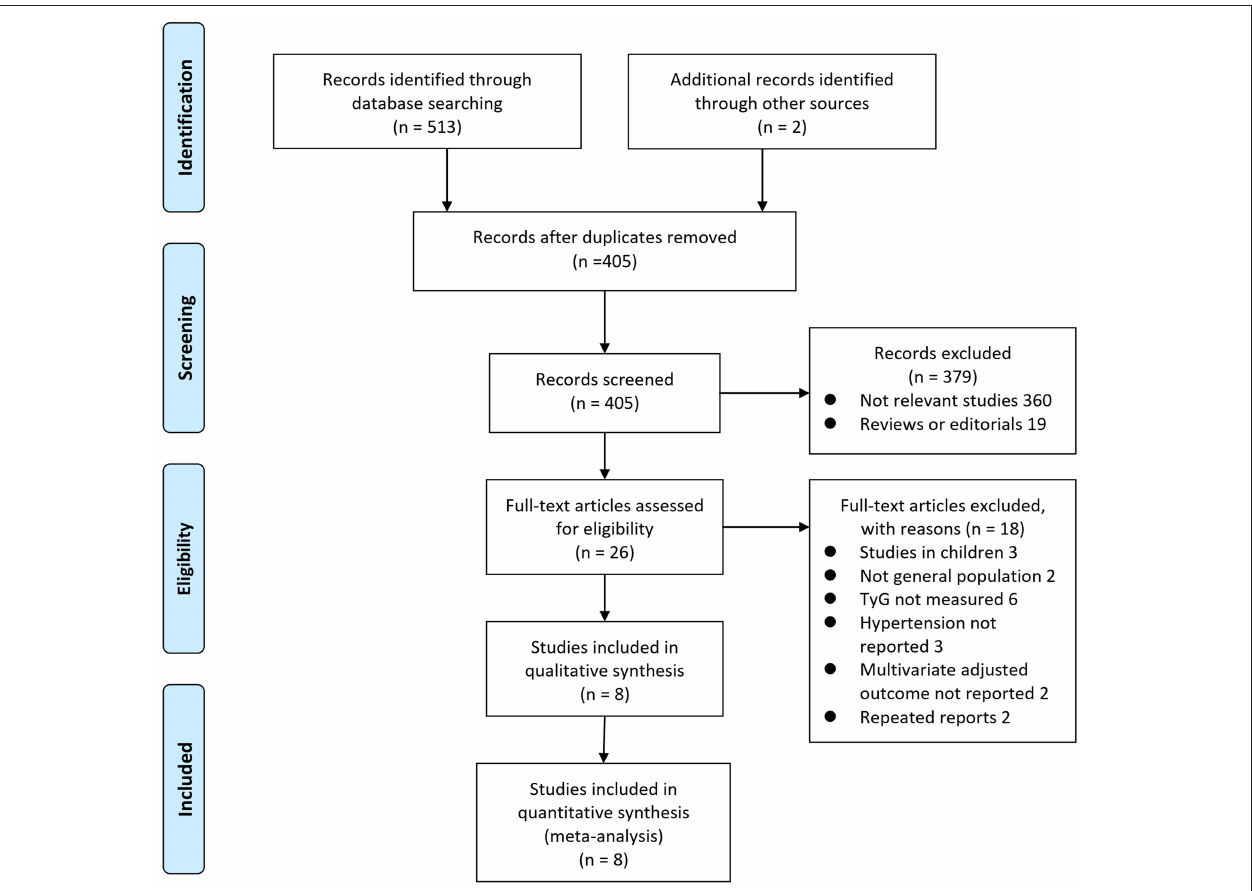
FIGURE 1 | Flowchart of database search and study